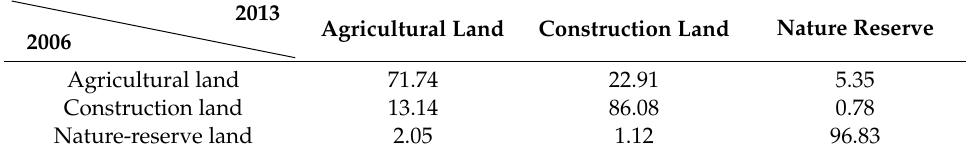
Table 6. The 2006–2013 transition-probability matrix (unit: